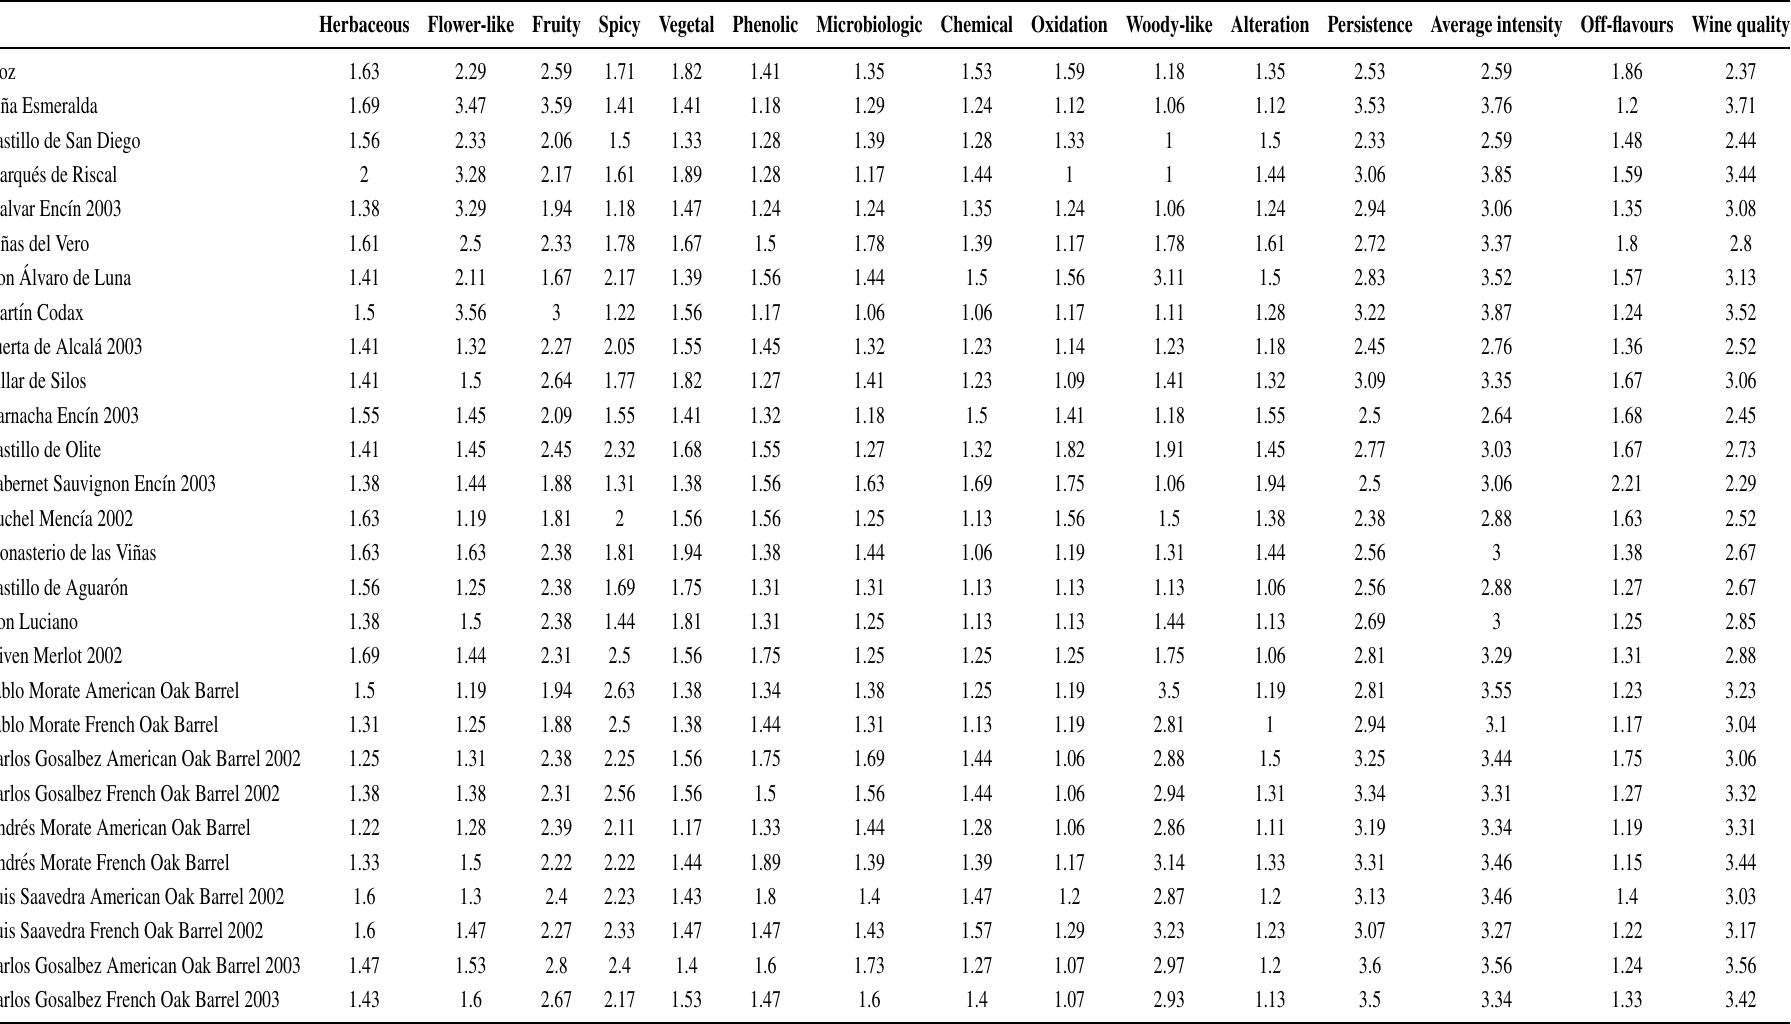
Table 2. Wine samples measured by the e-nose and tasted by the sensory